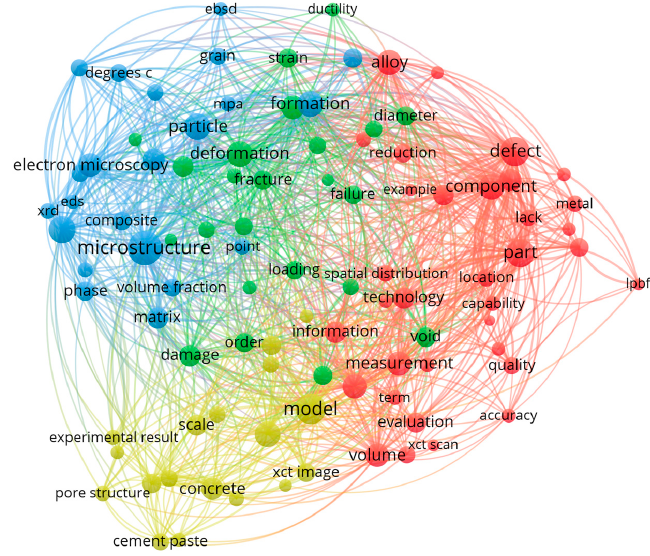
Figure 3. Map of related topics—xCT.